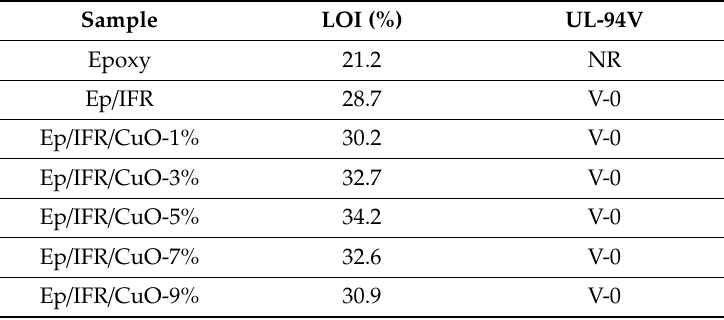
Table 3. Flame retardancy results of the samples.